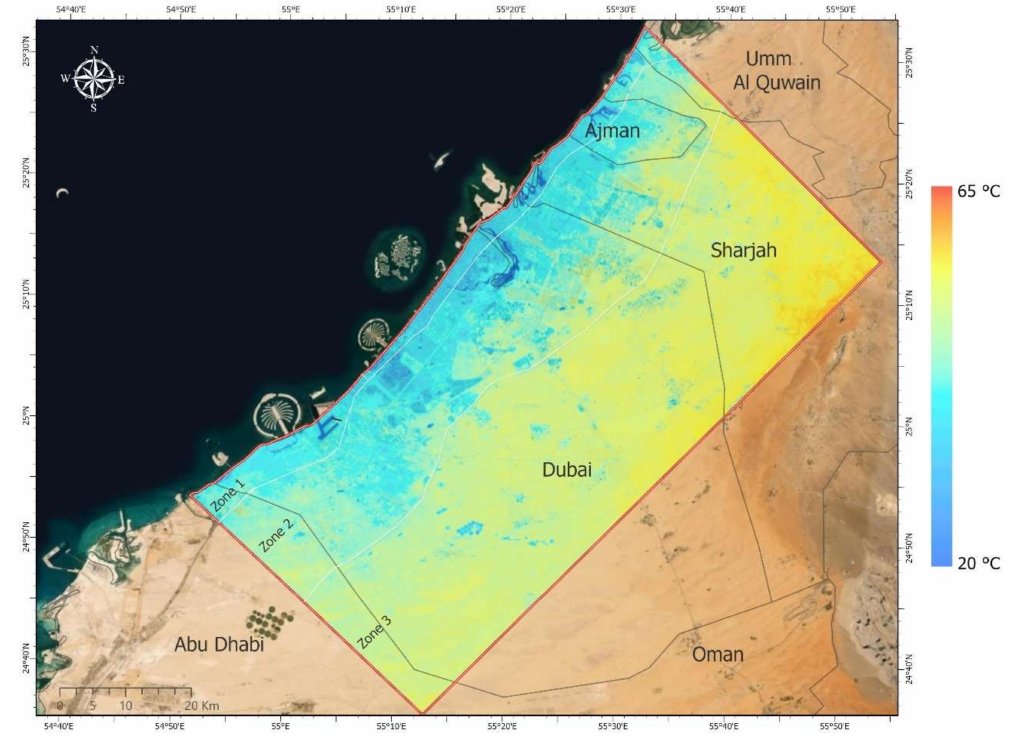
Figure 13. LST of August 2020 retrieved from Landsat